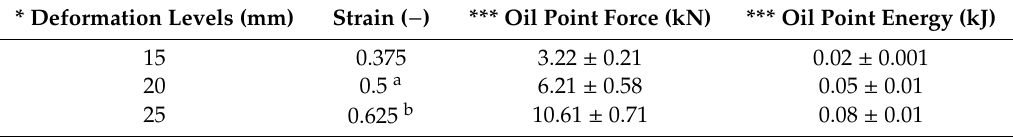
Table 5. Strain and oil point force of deformation levels of kernels at a speed of 4 mm / min. * Deformation Levels (mm)